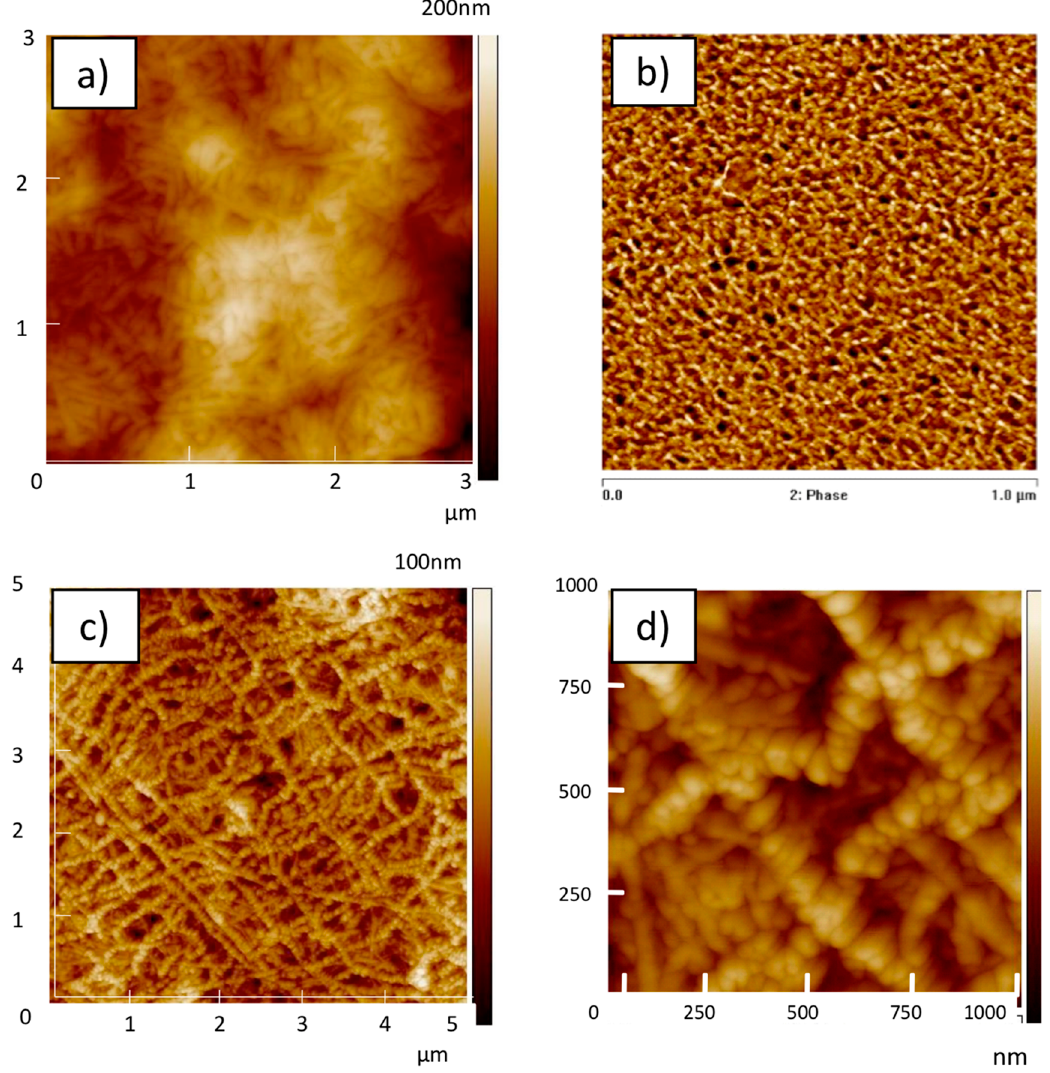
Figure 9. Representative atomic force microscopy (AFM) micrographs corresponding to ( a ) pure iPS xerogel, ( b ) pure metallo-organic polymer xerogel, and ( c , d ) hybrid iPS/metallo-organic polymer gel (with iPS/metallo-organic polymer ratio of 97/3).